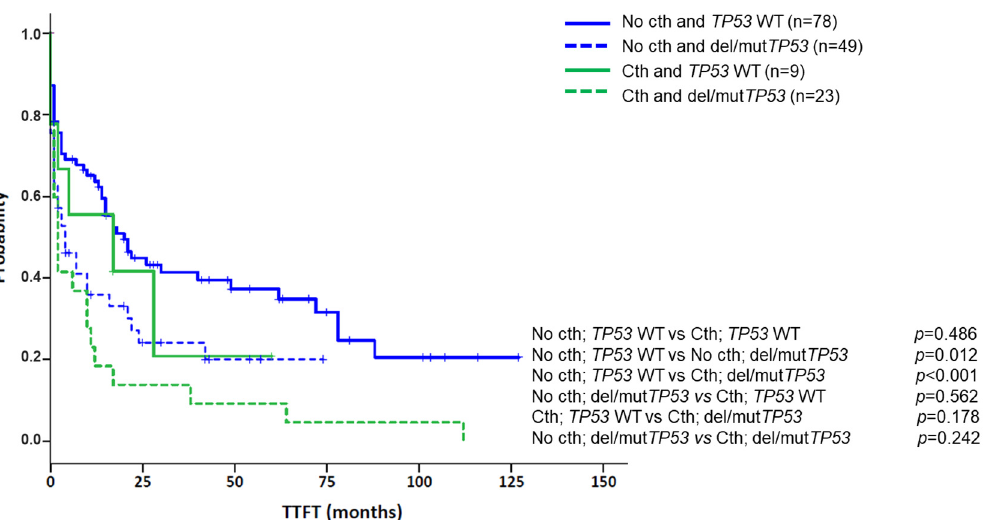
Figure 6. Kaplan–Meier plots for time to first treatment (TTFT) based on the presence of chromothripsis and abnormalities in TP53 (deletions and/or mutations). Patients were classified according to the presence of chromothripsis (cth) and within each group (No cth vs. Cth), TTFT was assessed based on the presence of aberrations in TP53 (deletions and/or mutations). On the other hand, no significant differences were observed based on IGHV status or del(11q) for TTFT in the whole cohort (Table 2) and among patients with cth (Cth group, n= 30, median TTFT: 1 m vs. 6 m, p = 0.412, for mutated-IGHV and U-IGHV, respectively;